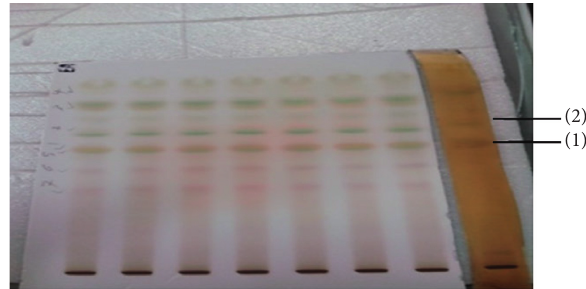
Figure 2: Bioautographic assay showing the inhibition of α -amylase by some compounds developed on a silica gel G60 F254 plate which was eluted with toluene : ethyl acetate : formic acid (5 : 4 :1, v/v/v) as the mobile